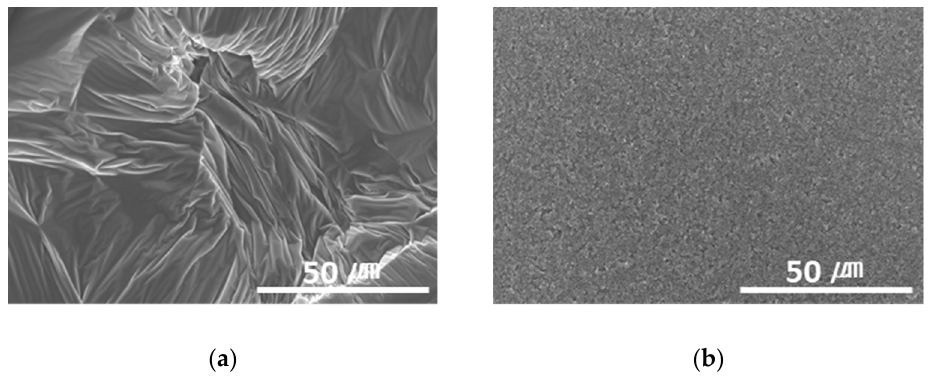
Figure 3. Surface morphologies of ( a ) graphene-12.0 and ( b ) MWCNT/C-15.0.